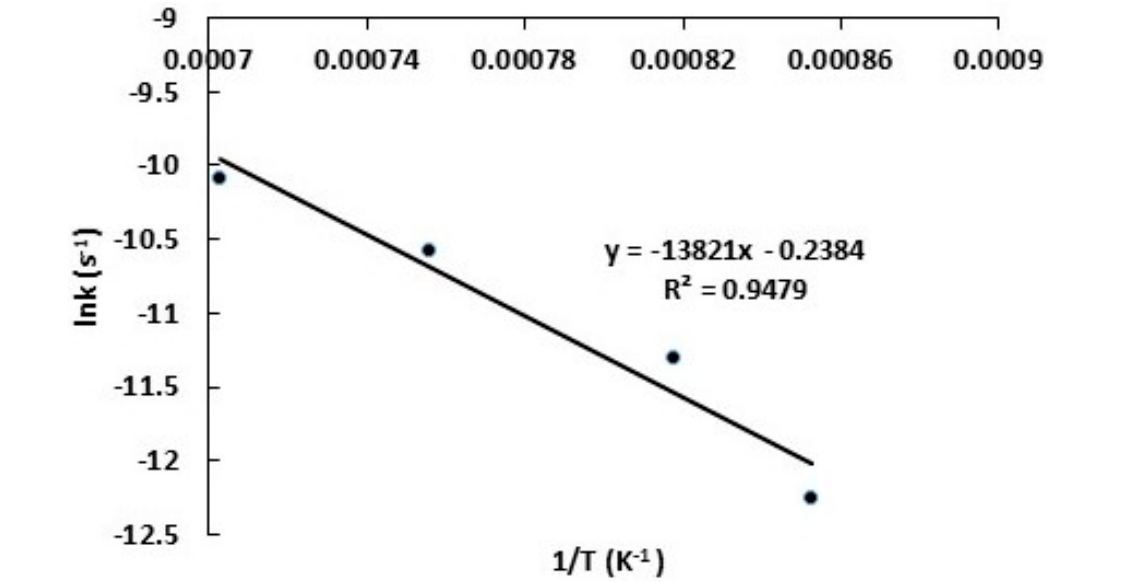
Figure 10. Arrhenius plot for barium sulfate conversion in powder sample.